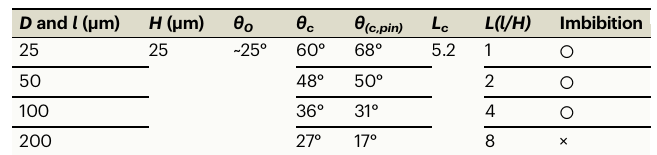
Table 1 | θ c , θ (c,pin) , and L as a function of the